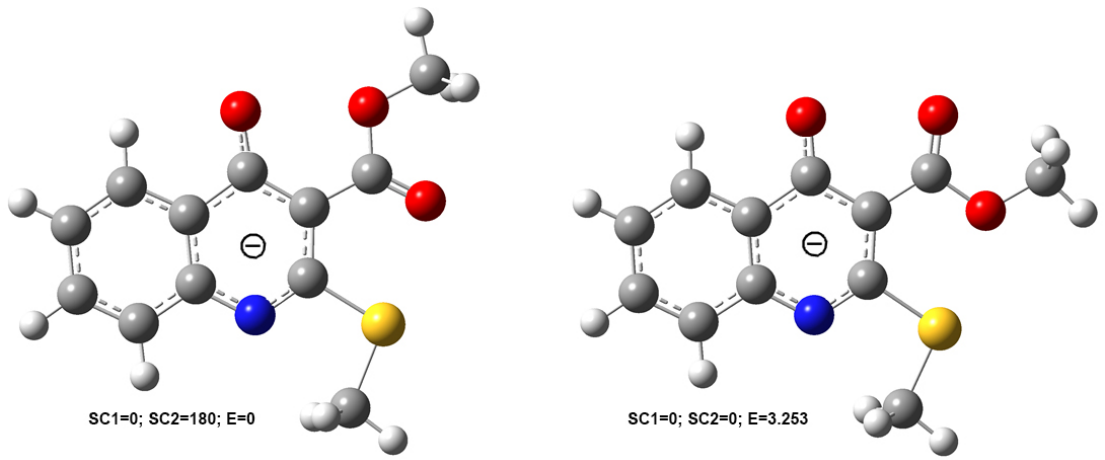
Figure 4. The most stable conformers of 3-(methoxycarbonyl)-2-(methylthio)-1,2-dihydroquinolin- 4-olate anion according to the conformational study.